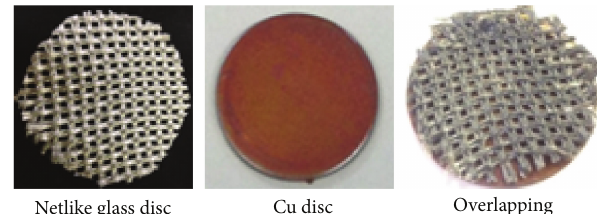
Figure 1: The base materials used for coating TiO 2